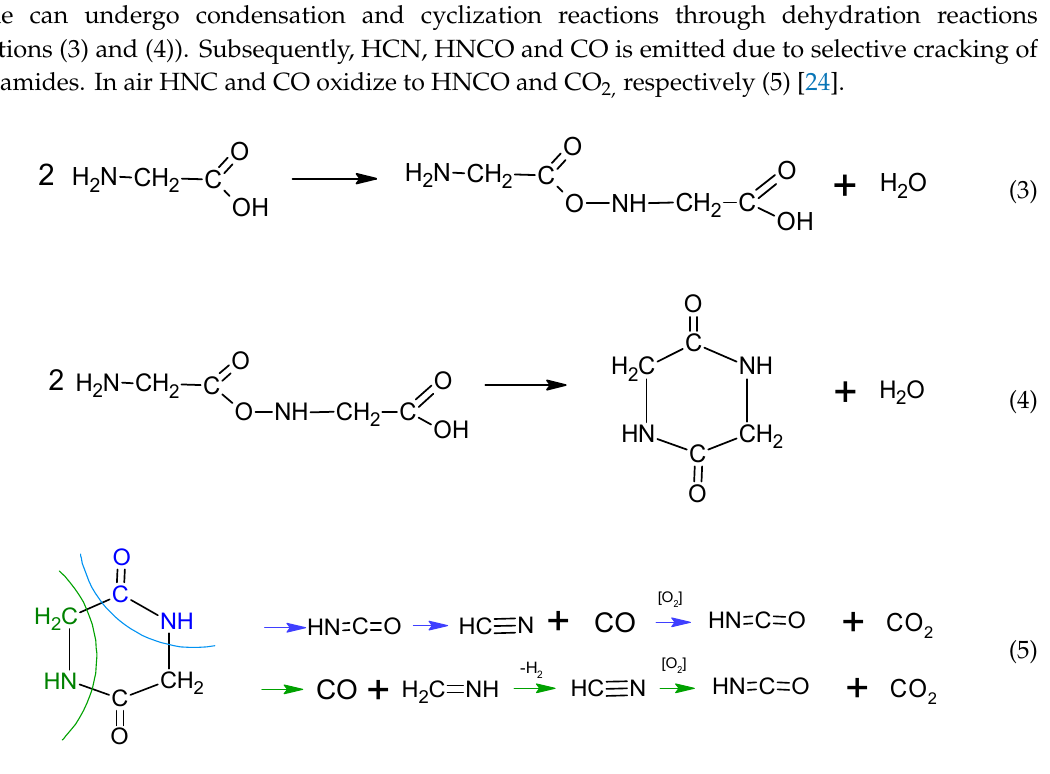
Figure 2. Thermal analysis results of the decomposition of glycine in synthetic air; absorbance intensities of traces for wavenumbers: 2243, 3324, 962, 2367 and 3740 cm − 1 corresponding with absorbance peaks of HCNO, HCN, NH 3 , CO 2 and H 2 O,